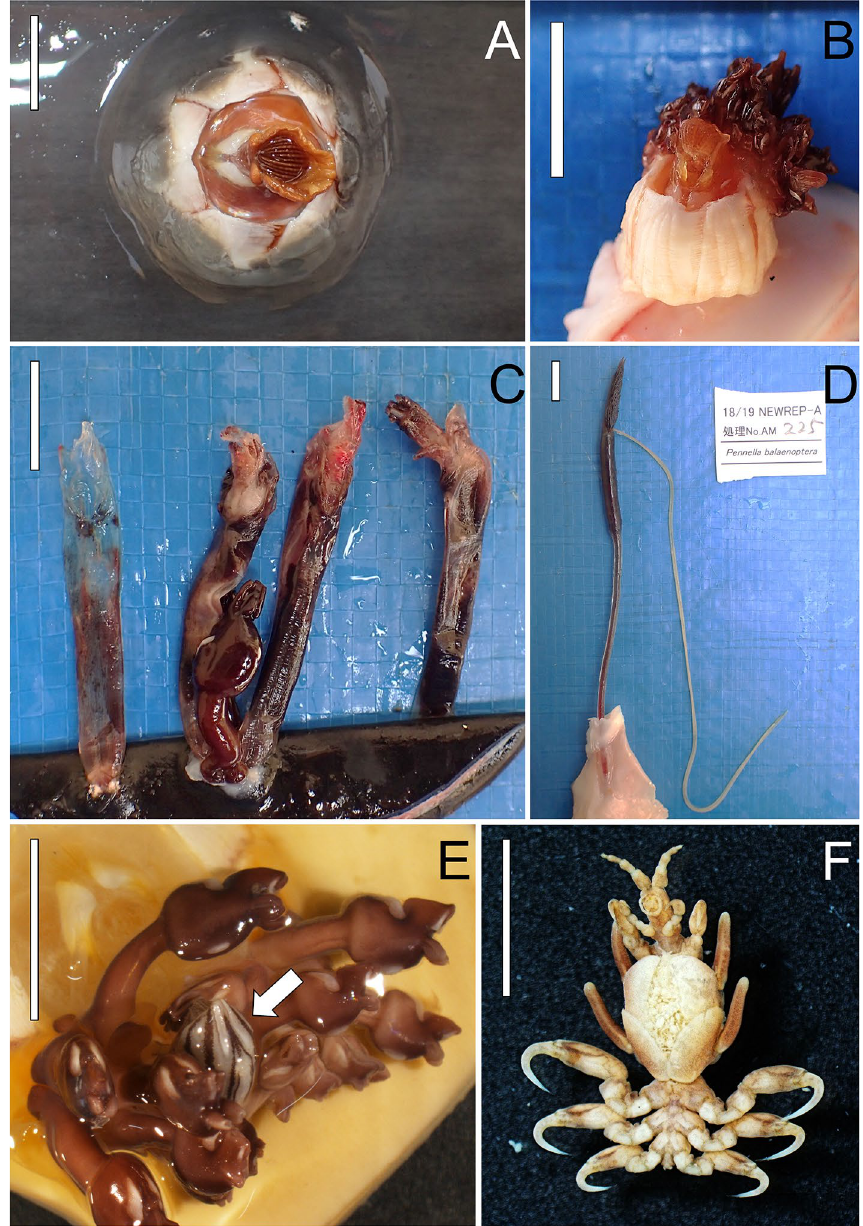
Figure 2. Epibiotic fauna of the Antarctic minke whale, Balaenoptera bonaerensis , captured in the Southern Ocean. ( A ) Coronula reginae , ( B ) Coronula diadema (with Conchoderma auritum attached to the shell), ( C ) Xenobalanus globicipitis showing a variable degree of tissue degradation (the leftmost specimen was scored as degree 2 and the three remaining ones as degree 1; see the text) and one individual of C. auritum on one shell, ( D ) female of Pennella balaenoptera with egg strings, ( E ) a single individual of Conchoderma virgatum (arrow) among individuals of C. auritum on the shell of C. reginae , ( F ) female of Balaenocyamus balaenopterae with offspring in the marsupium. Scalebar: 1